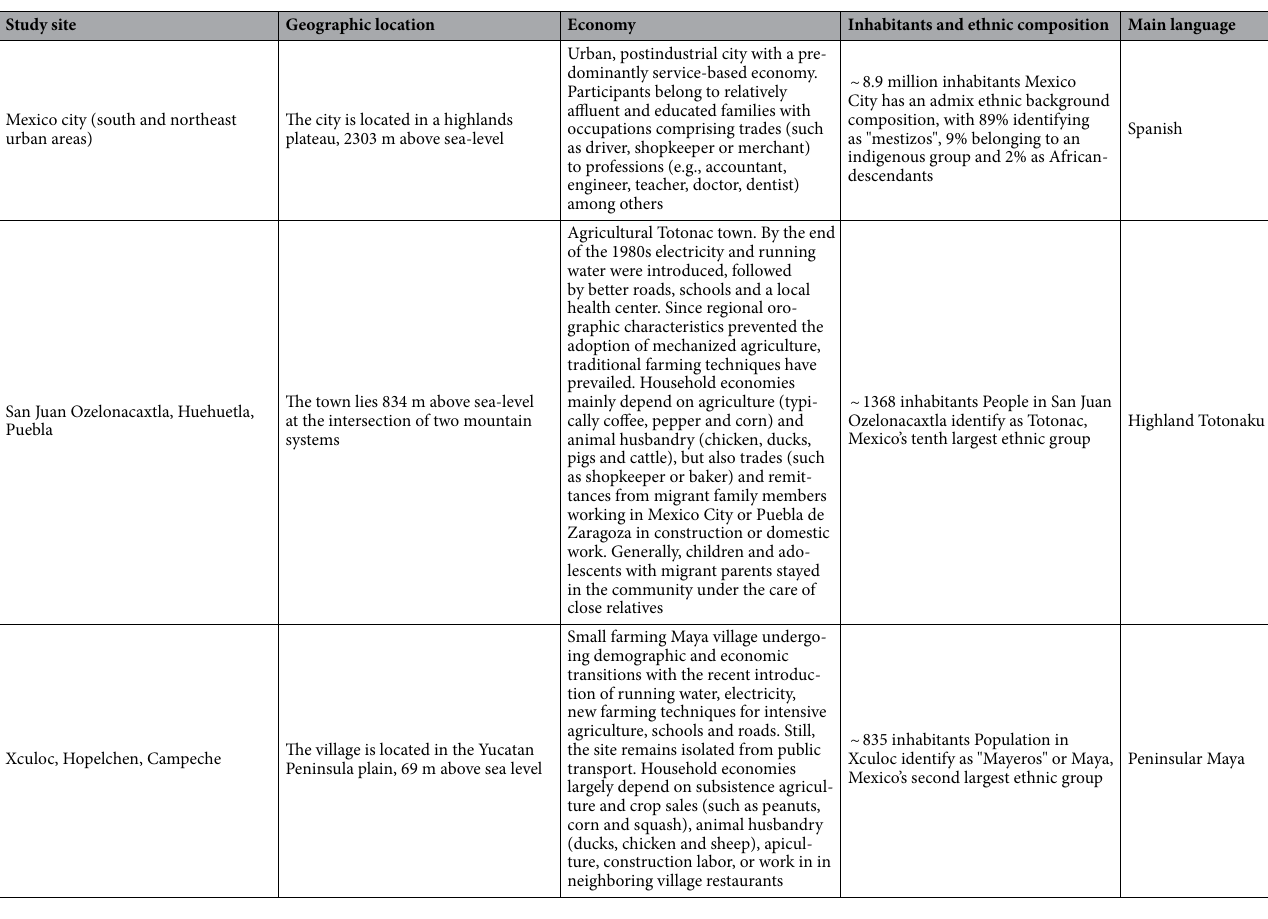
Table 2. Characteristics of the study